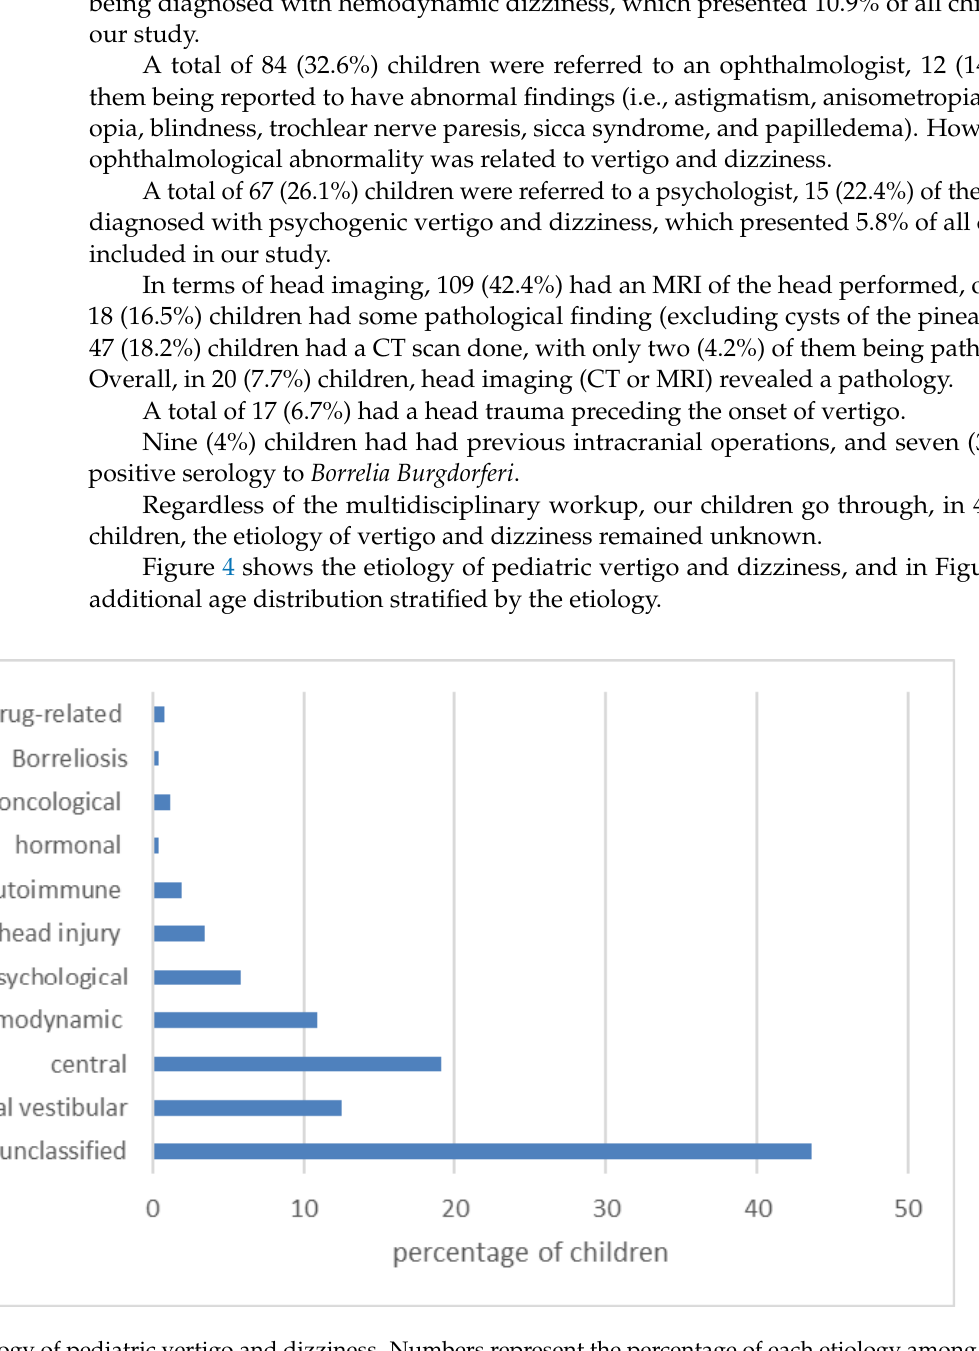
Figure 4. The etiology of pediatric vertigo and dizziness. Numbers represent the percentage of each etiology among 257 referred children.